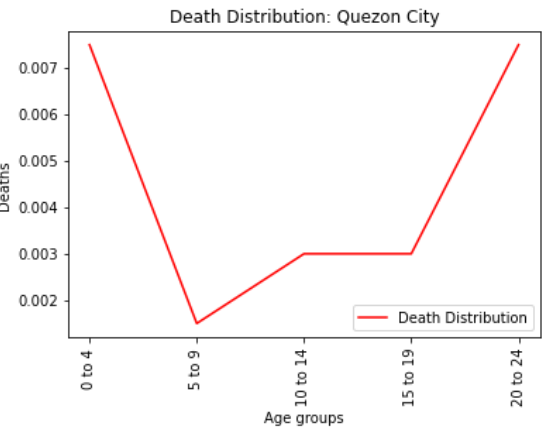
Figure 5. COVID-19 Death Distribution in Quezon City, Philippines as of October 24,